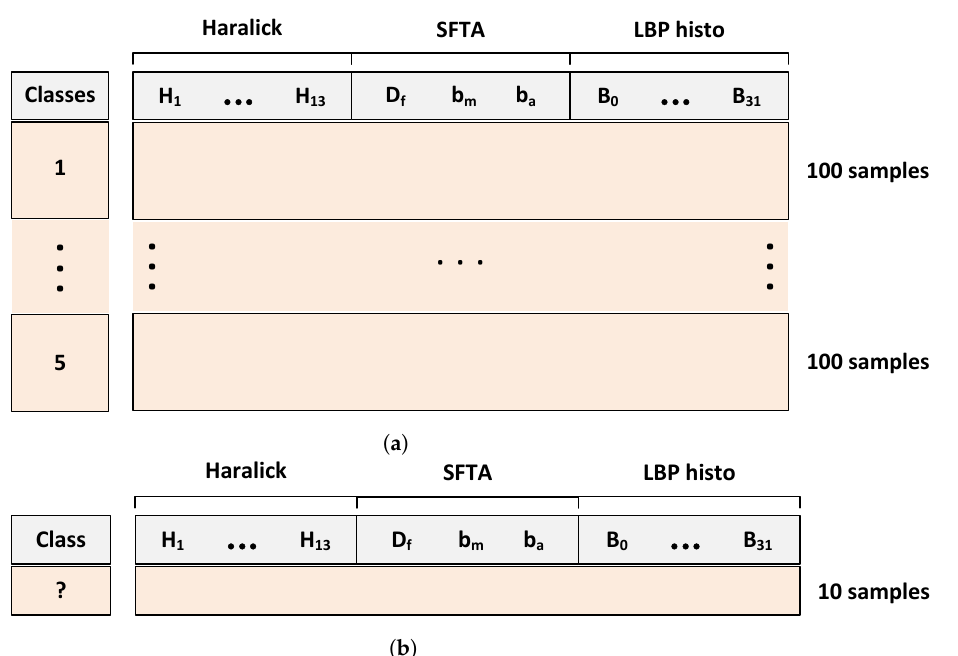
Figure 12. Dataframes of textural features, ( a ) in the training mode, ( b ) in the prediction mode.